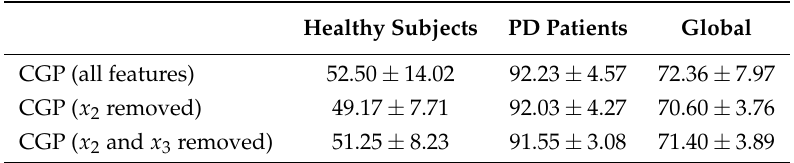
Table 7. Recognition rates per class and global accuracy ( mean ± sd ) for the original meander dataset and reduced versions.